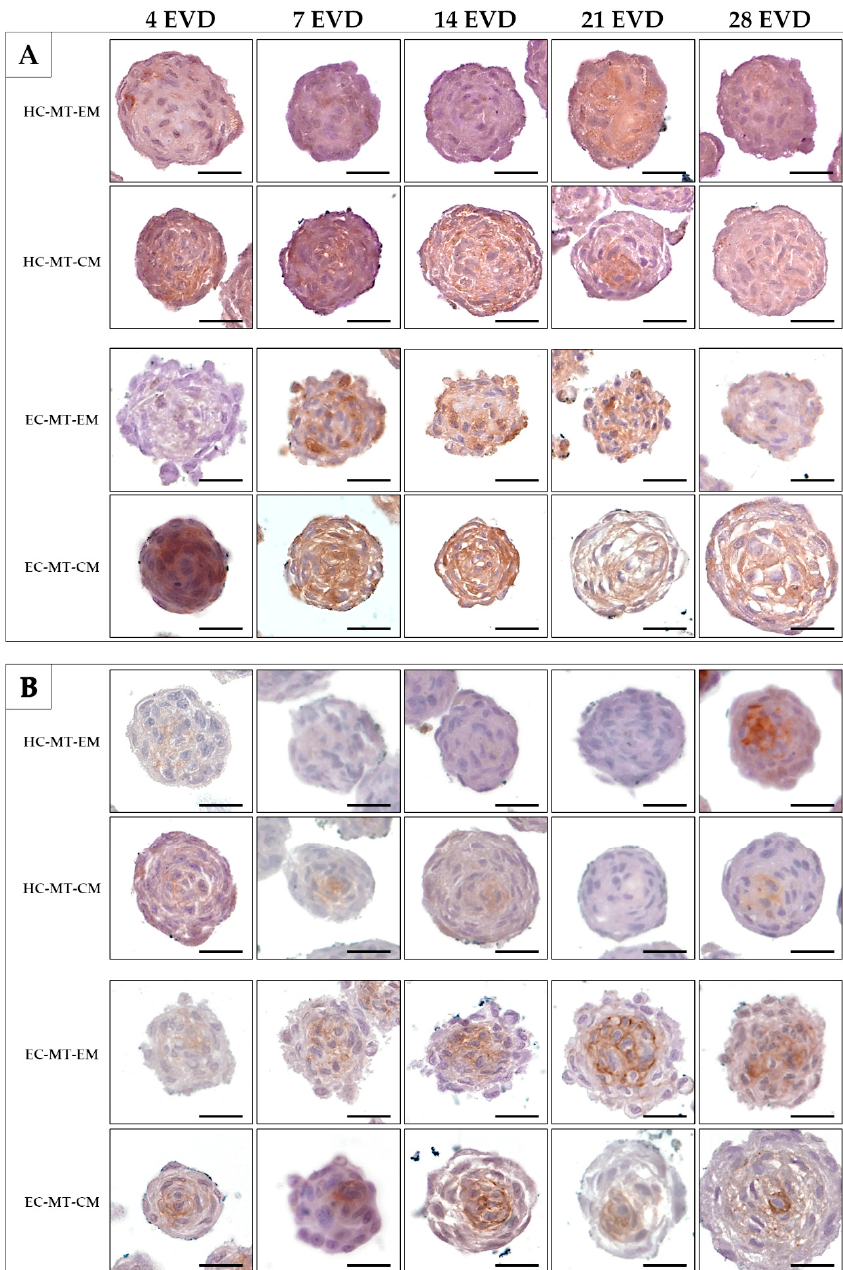
Figure 8. Histochemical analysis of expression of collagen type II (Col II) ( A ) and collagen type IV (Col IV) ( B ) of HC-MTs and EC-MTs under CM and EM. CM-MTs show higher reaction to Col II ( A ) in both cell types. Note the positive reaction to Col IV in EC-MTs ( B ). For all pictures, scale bar = 50 µm.